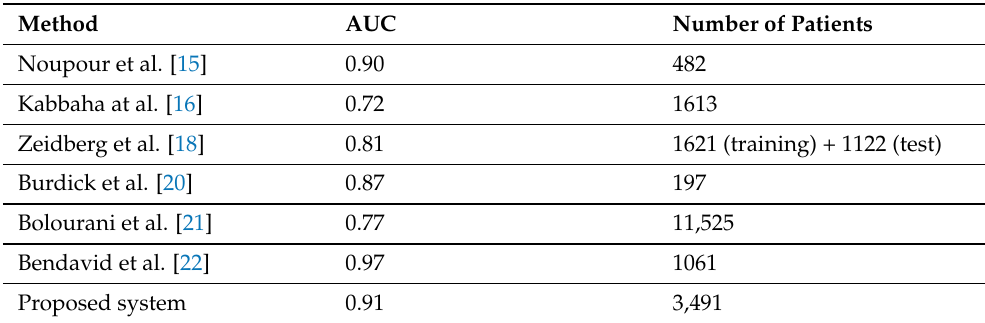
Table 6. Quantitative Comparison between our method and other methods in the literature. AUC: area under the